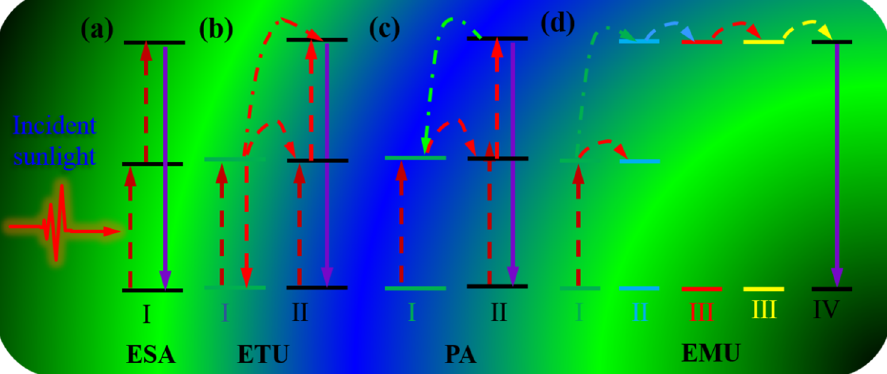
Figure 2. A schematic illustration of four typical upconversion processes: ( a ) Excited state absorption (ESA); ( b ) Energy transfer upconversion (ETU); ( c ) Photon avalanche (PA); ( d ) Energy migration-mediated upconversion